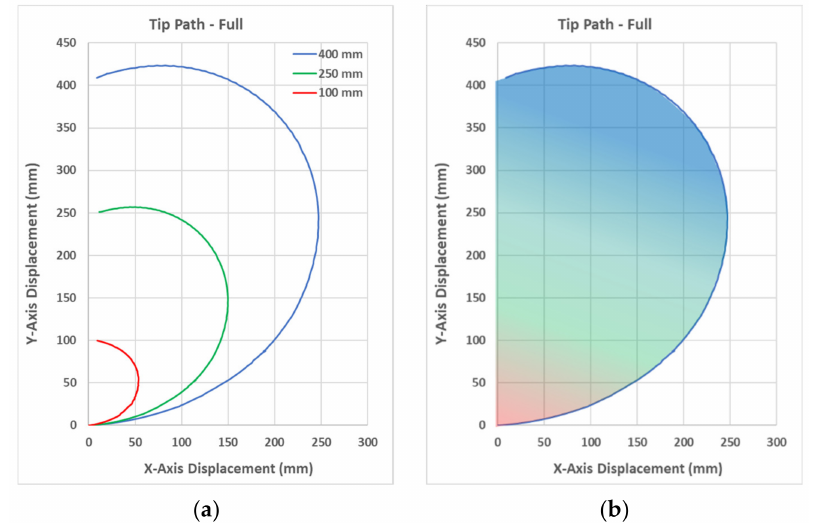
Figure 9. The results obtained from the simulation: ( a ) Arm tip trajectories for three bending segment lengths. ( b ) Planar